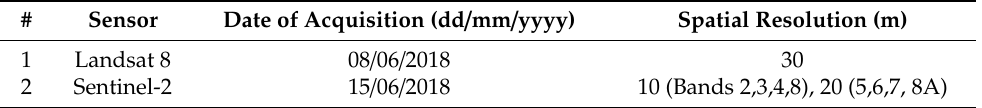
Table 1. Satellite imageries used in the study.